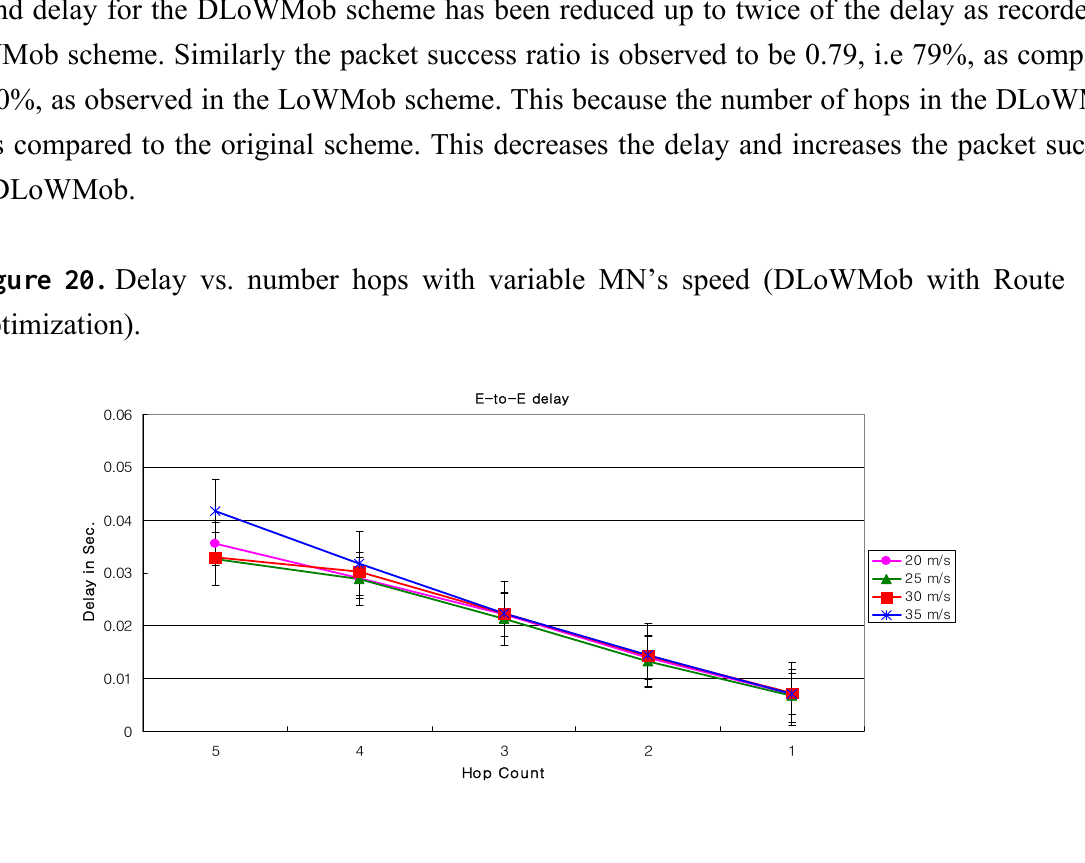
Figure 21. Packet Success Rate vs. number of hops with variable MN’s speed (DLoWMob with Route